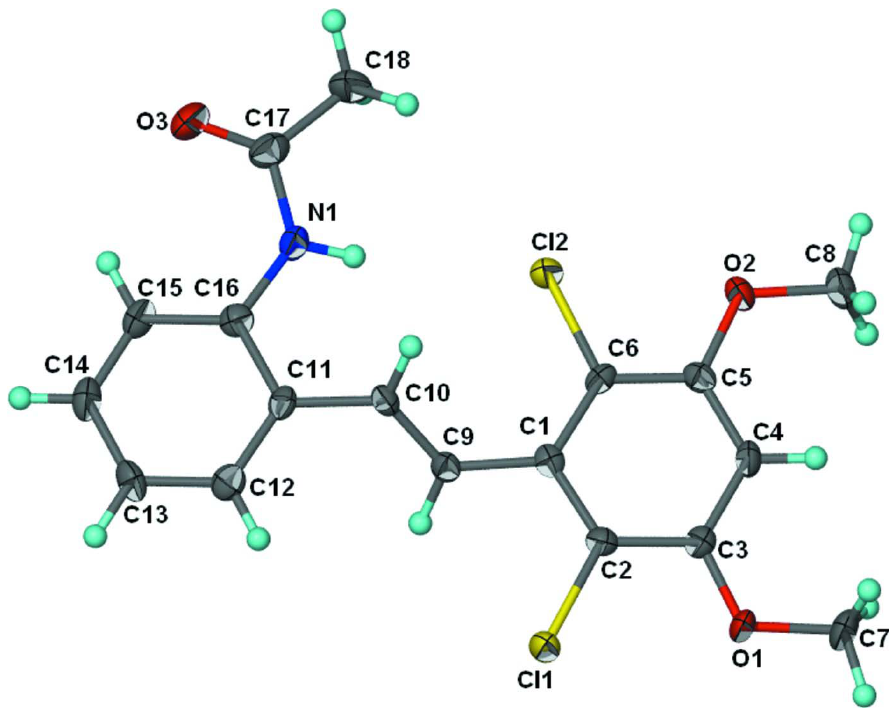
H Cl NO at the 70% probability level. H atoms are drawn as spheres of 18 17 2 3